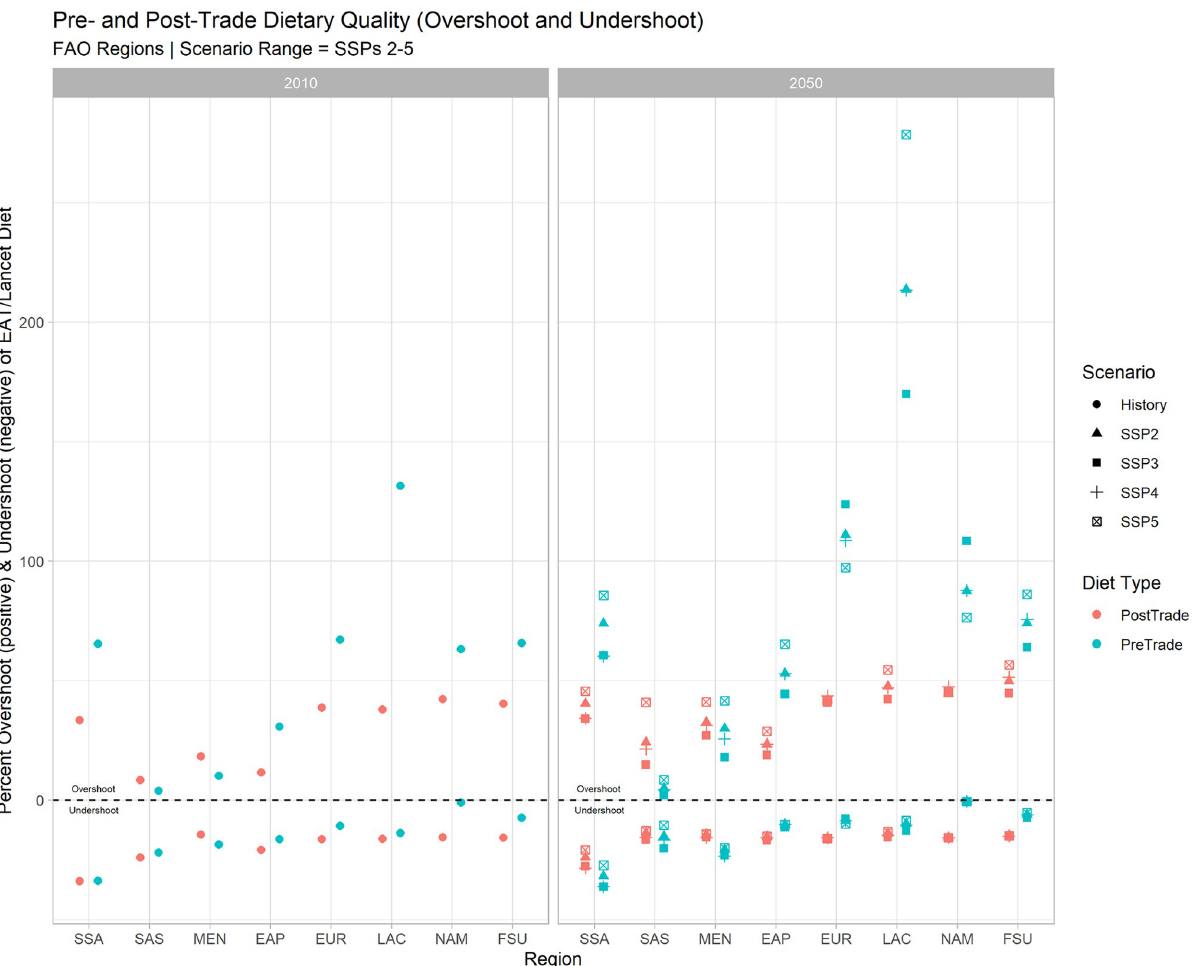
Fig 5. Regional comparison of “pre-trade” (production-only) average diets and actual average diets in overshoot and undershoot terms. Regional- level metrics are constructed as a population-weighted mean of average country-level dietary undershoot or